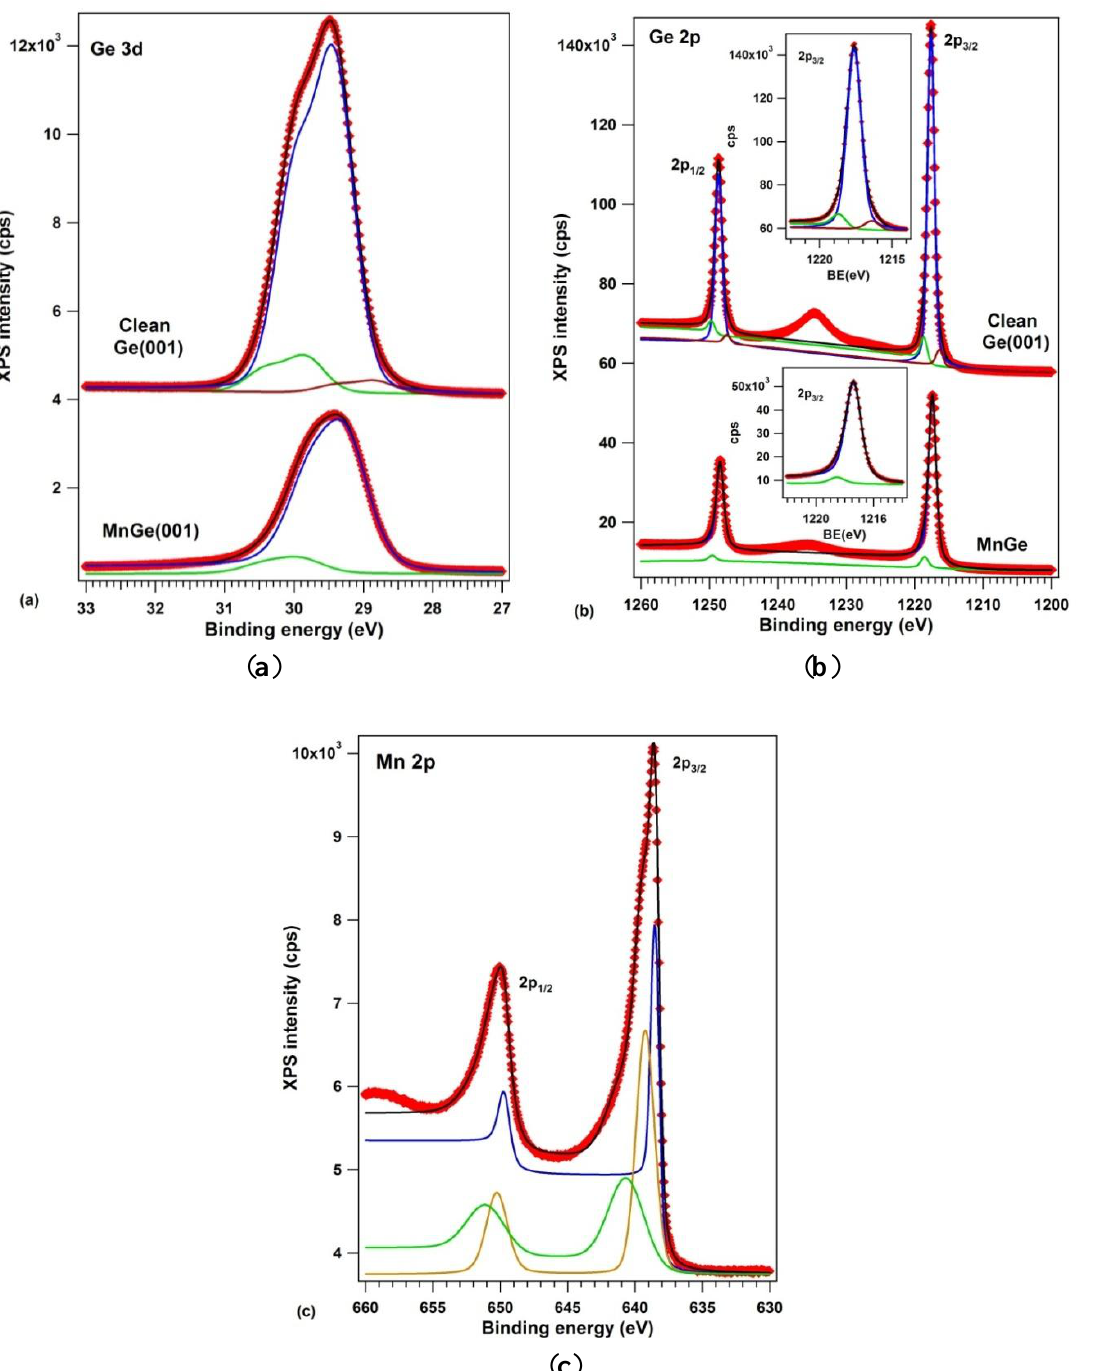
Figure 6. X-ray photoelectron spectroscopy (XPS) results: ( a ) Ge 3d core levels; ( b ) Ge 2p core levels and ( c ) Mn 2p core levels. For ( a ) and ( b ), the spectra obtained on a clean Ge(001) (2 × 1) are also represented. All spectra are fitted by using Voigt doublets and integral inelastic backgrounds (see the Experimental section for details). Inserts in ( b ) are detailed regions of the Ge 2p core level. 3/2